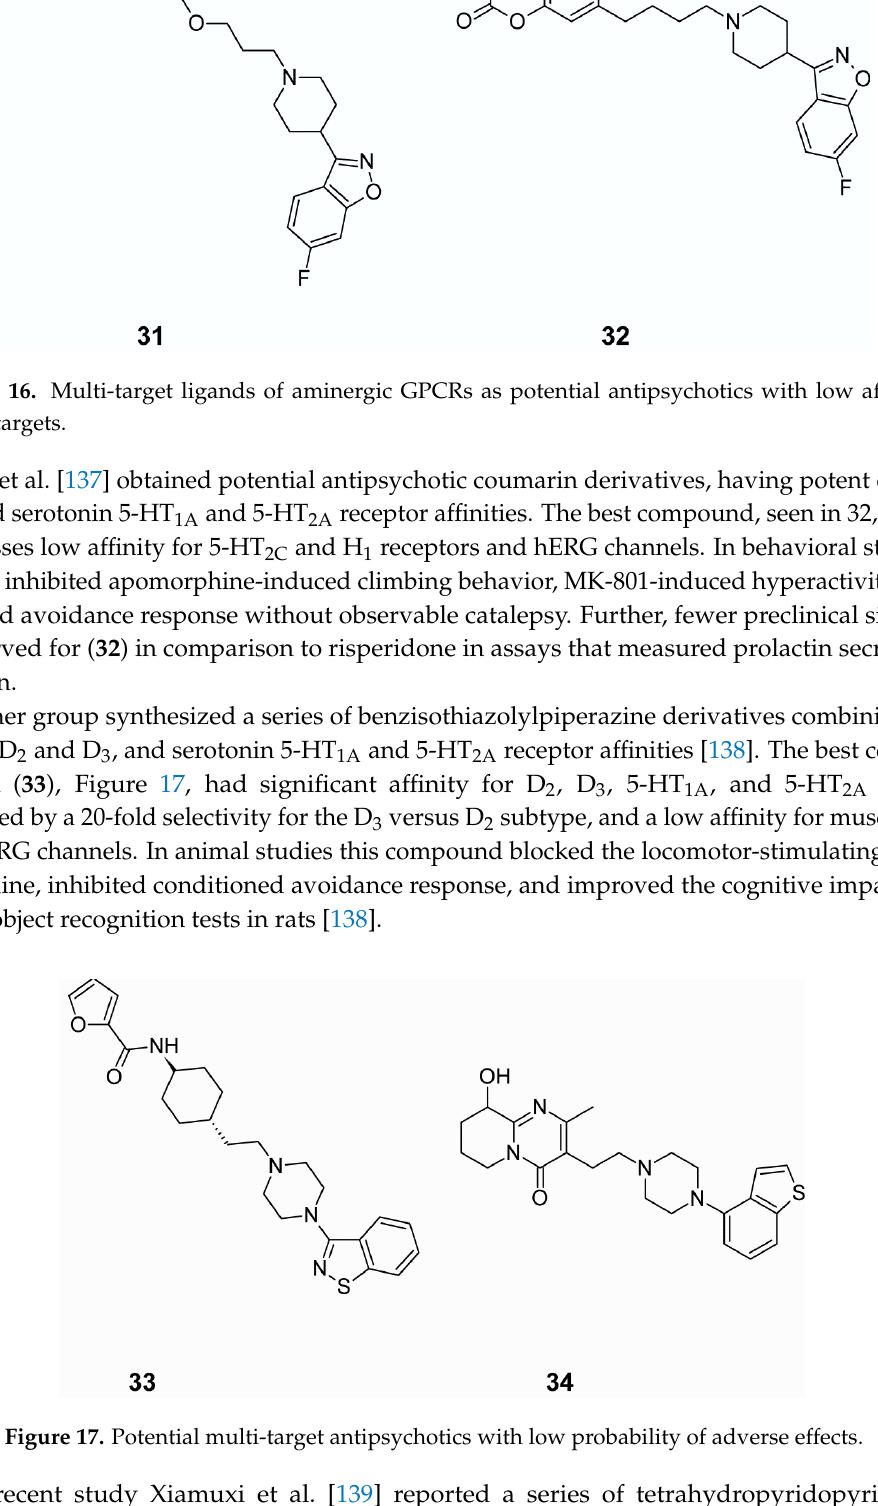
1A and 5-HT 2A receptor binding affinities. The best compound ( 31 , Figure 16) had